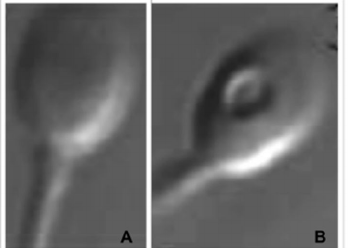
Figure 1. Human spermatozoa observed at high magnification with differential interference contrast (DIC) microscopy (IMSI-like). ( A ) A grade I morphometrically normal spermatozoon with no vacuole. ( B ) A grade III morphometrically normal spermatozoon with one large vacuole. The selected spermatozoa were distributed over five 10-well slides in phosphate- buffered saline (PBS) (Biom é rieux, France): 20–25 normal spermatozoa in one well and 20–25 vacuolated spermatozoa on the diagonal opposite well. Altogether, more than 4000 spermatozoa (n = 4193 spermatozoa) were assessed, and for each epigenetic mark, more than 800 spermatozoa (more than 20 vacuolated and 20 vacuole-free spermatozoa from the twenty patients) were analyzed at the gamete level. The protocol is summarized in Figure 2. After sperm selection, slides were immediately air-dried, and spermatozoa fixed with cold methanol for 10 min at 4 ◦ C. After fixation, slides were air-dried and conserved at − 20 ◦ C until further